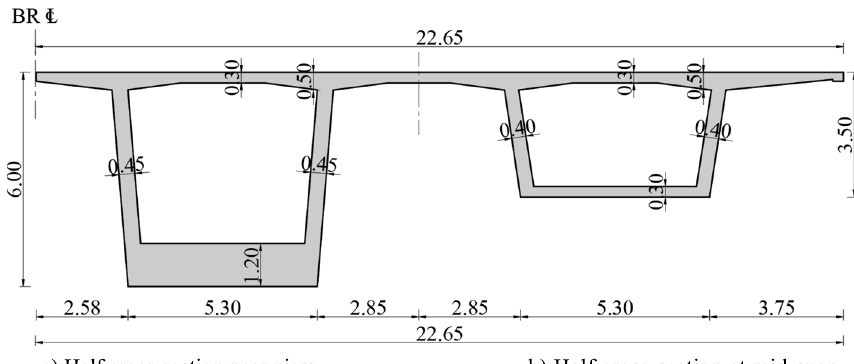
Fig. 3 Typical cross-sections of El-Warrak Bridge. a Half cross-section near piers. b Half cross-section